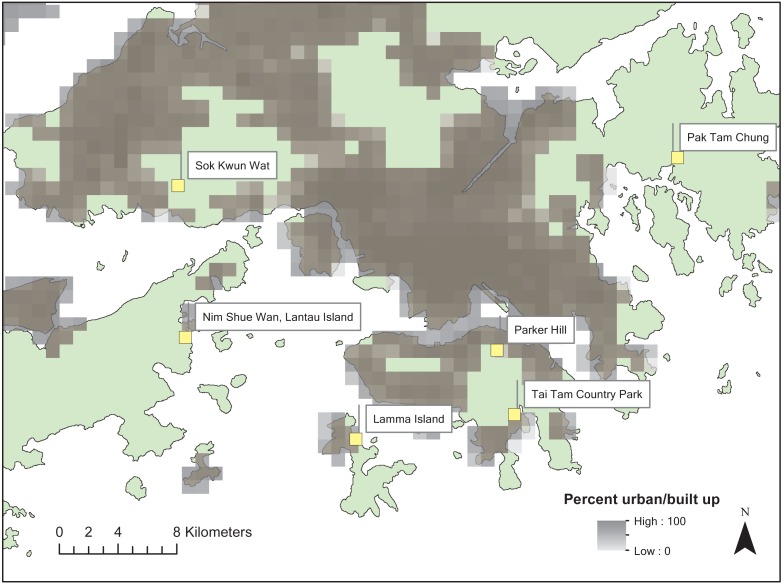
Map of the study sites across Hong Kong.Percent urban area is based on the one km resolution land cover dataset of Tuanmu & Jetz (2014).